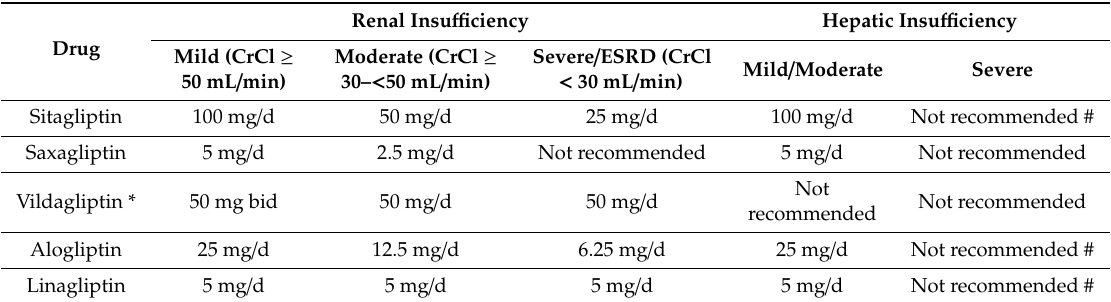
Table 2. Dosage of DPP-4 inhibitors in renal and hepatic insu ffi ciency. Renal Insu ffi Drug